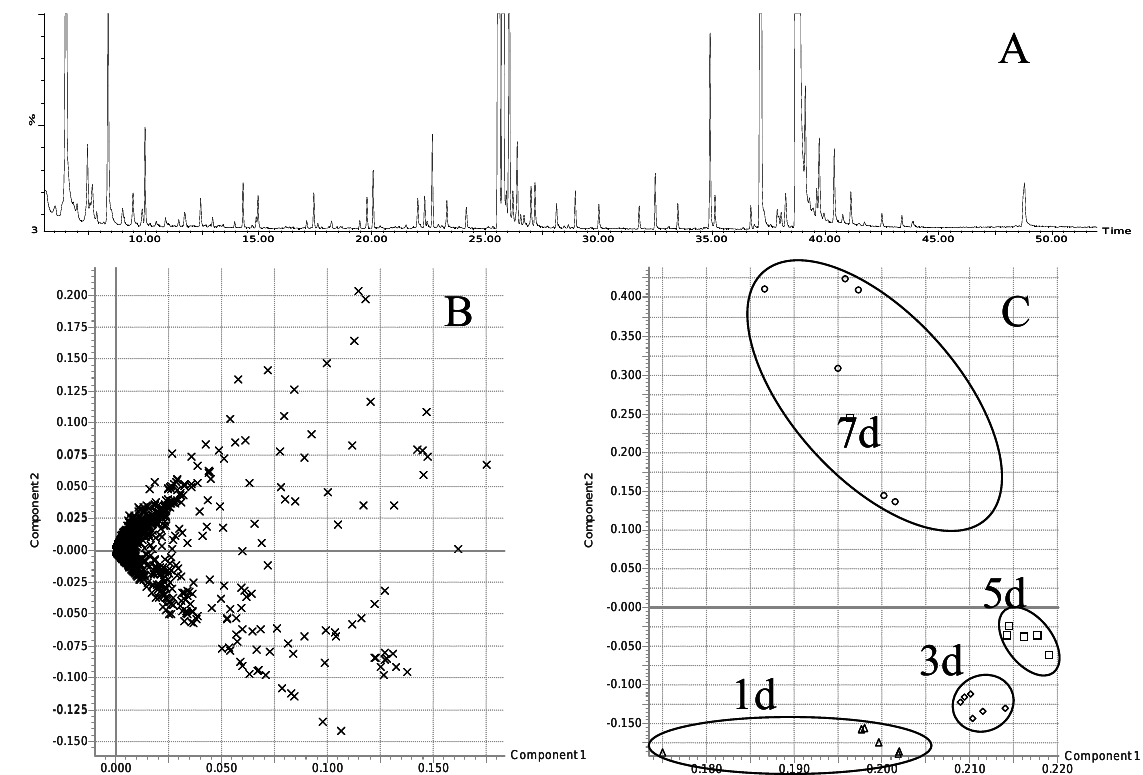
Figure 6. GC-MS analysis of extracellular metabolite profiles from S2LS3 cell culture medium after derivatisation. Exact mass retention time pairs (EMRT) were used for principle component analysis